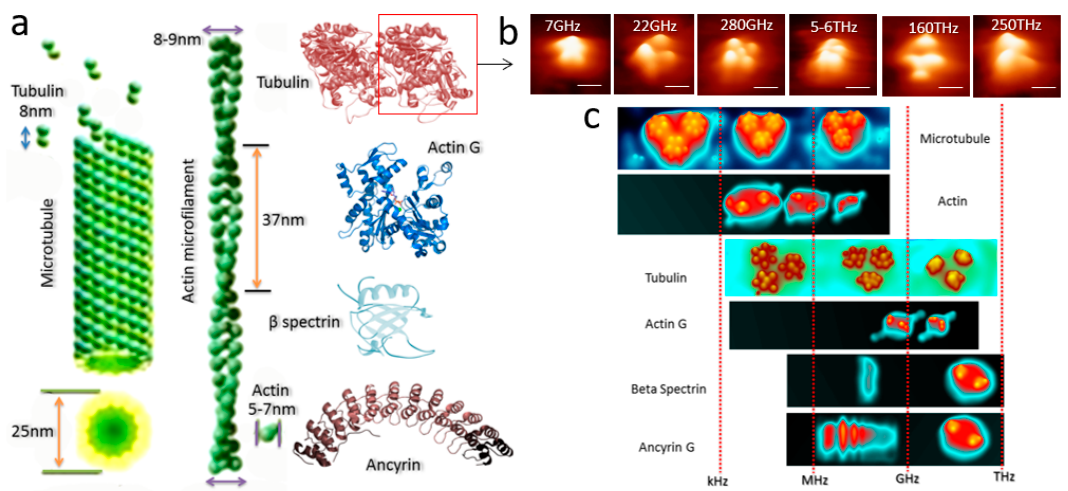
Figure 4. Generalization of 3D resonance bands for actin, β -spectrin and Ankyrin G; ( a ) Microtubule microfilaments, its constituent tubulin, actin protofilament and its constituent Actin G, Ankyrin and beta spectrin protein structures (pdb database); ( b ) Scanning Tunneling Microscope (STM) images of themonomerofasingletubulinprotein, theexternallyappliedACfrequenciesatwhichtheconformation was imaged via tunneling current is shown in the top right corner. Scale bar = 3 nm; ( c )